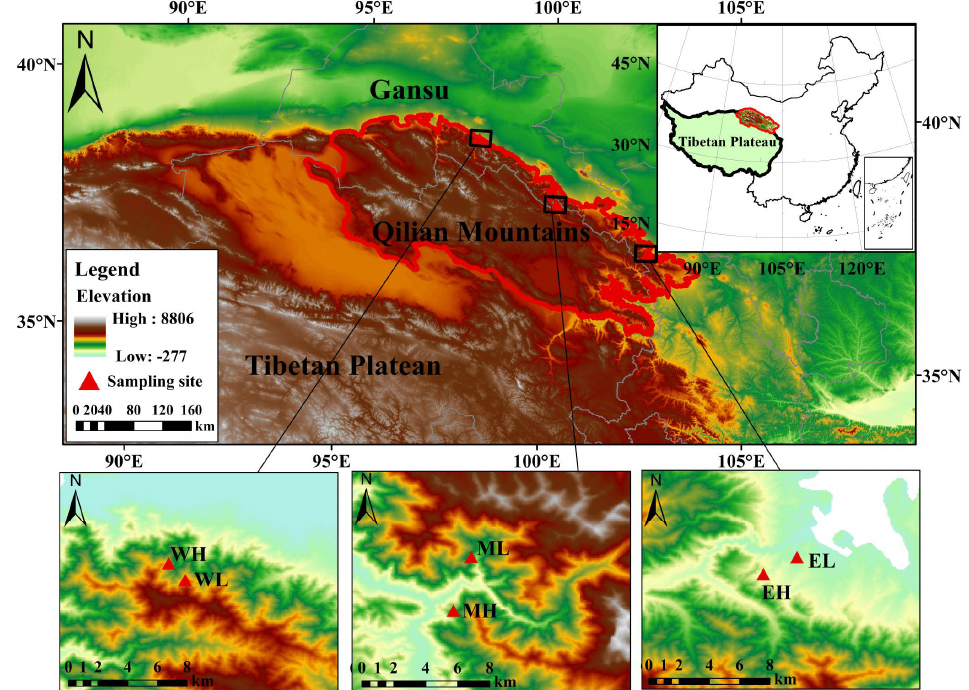
Figure 1. Study regions and distribution of sampling sites at different elevations.